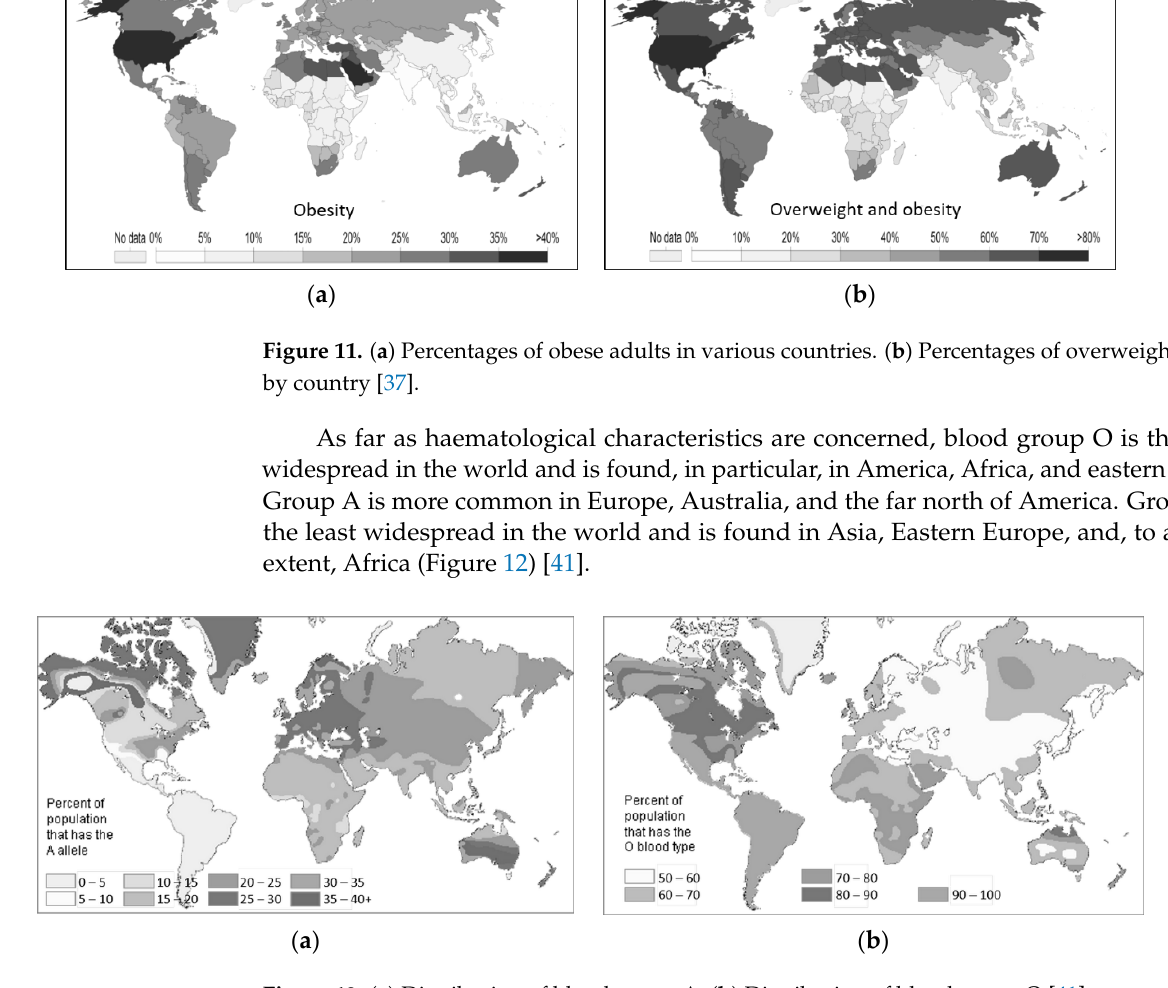
Figure 11. ( a ) Percentages of obese adults in various countries. ( b ) Percentages of overweight adults by country [37].